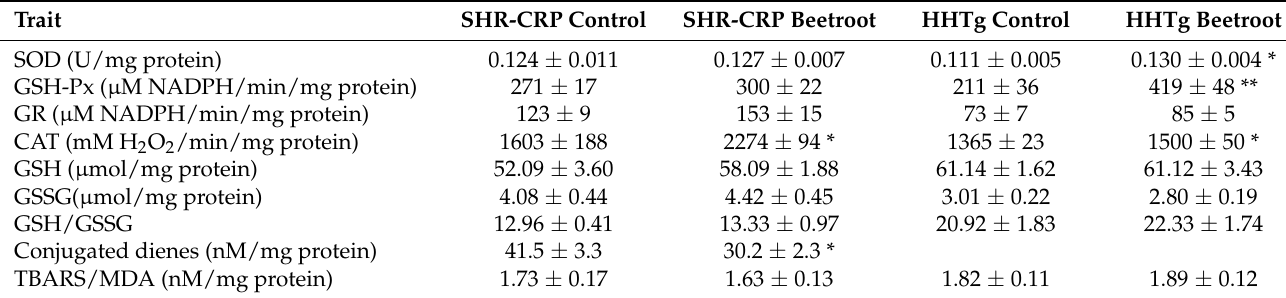
Table 3. Oxidative stress parameters in the liver.